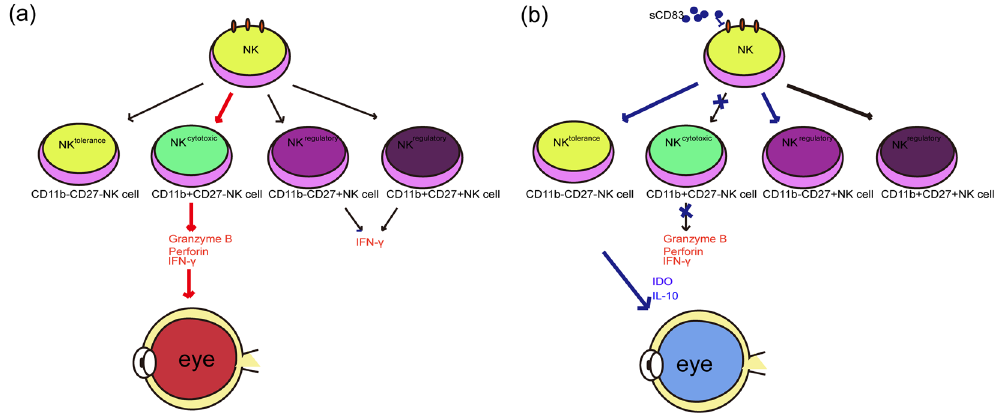
Figure 7. Diagram of the role of NK cells in the EAU model and effects of sCD83 regulation of the NK cells involved with ameliorating effects of EAU. ( a ) NK cells in EAU consist primarily of CD11b high CD27 low NK cells, which secrete Granzyme B, perforin and IFN- γ to result in pathological ocular damage. ( b ) sCD83 treatment decreases the expression of CD11b on NK cells to decrease the proportion of CD11b high CD27 low NK cells, thereby increasing the proportion of CD11b low CD27 low NK cells in the periphery to reduce the cytotoxic effect of NK